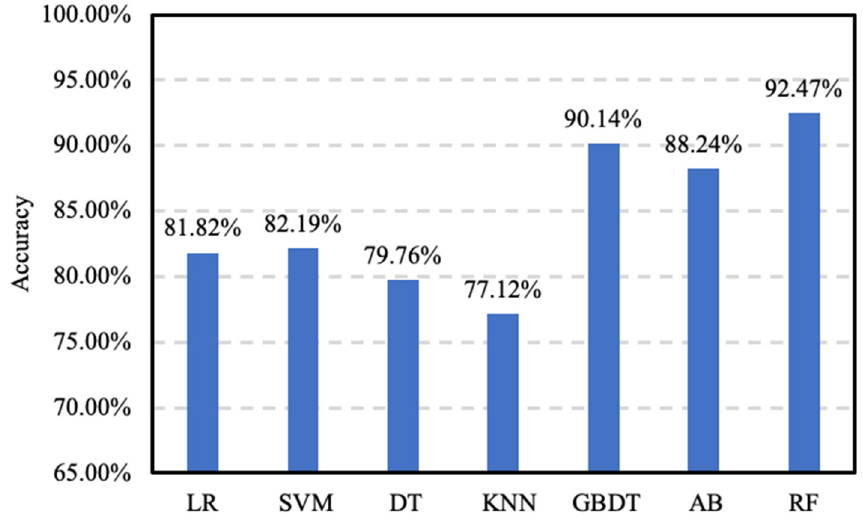
Figure 12. The accuracy of different classification algorithms on the training set.